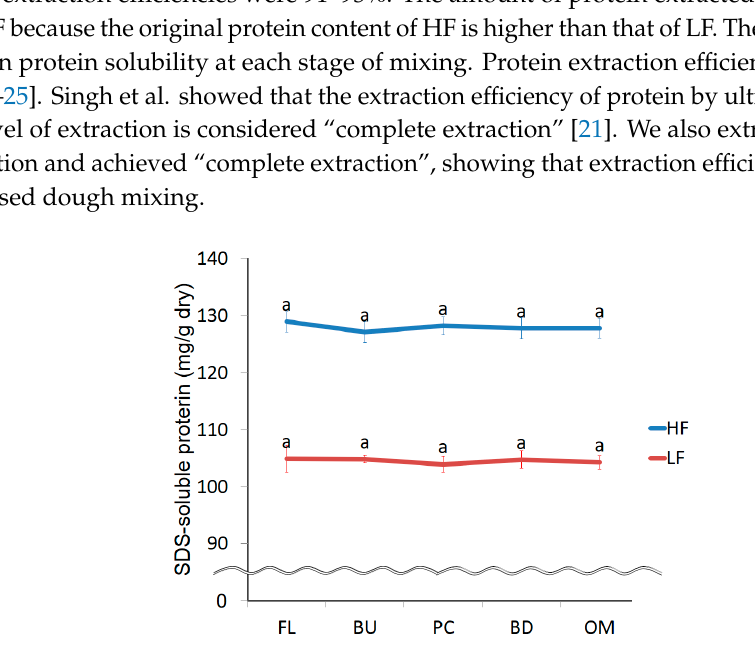
Figure 3. Change in the amount of 0.5% SDS-soluble protein during mixing. FL, BU, PC, BD, and OM indicate flour (before mixing), build up, peak consistency, breakdown, and overmixing, respectively. HF and LF mean high protein flour and low protein flour. The error bars show standard deviations (n = 12). Identical letters on the graph indicate no significant difference ( p < 0.05).